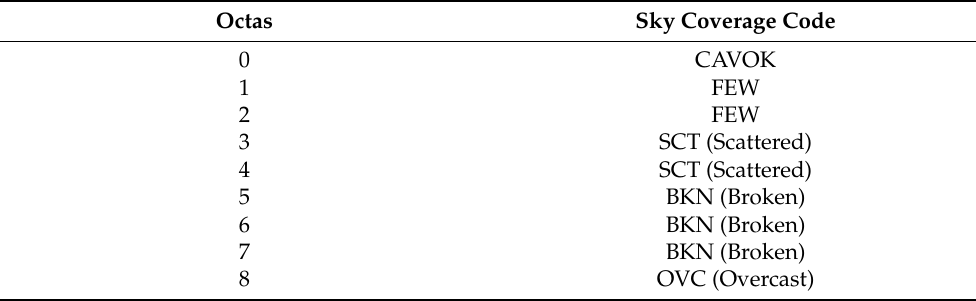
Table 1. Metar sky coverage oktas and codes.